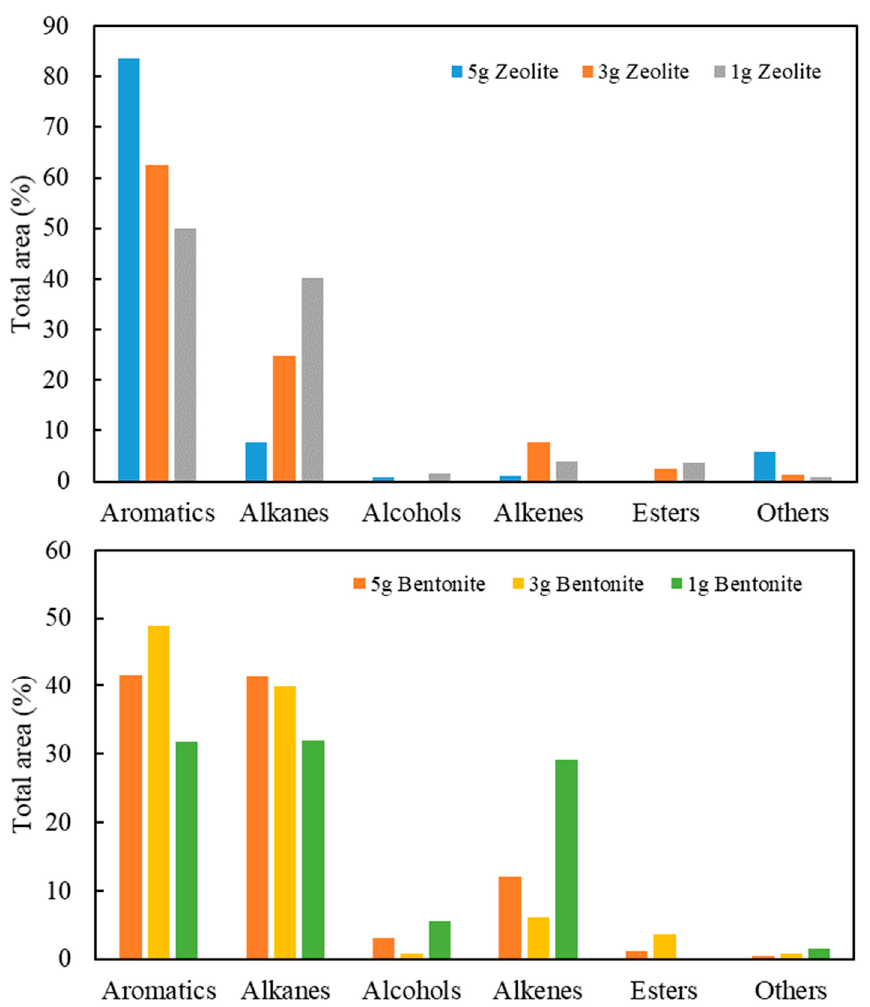
Figure 9. Identified compounds for catalytic pyrolysis using the different weights of zeolite and bentonite.